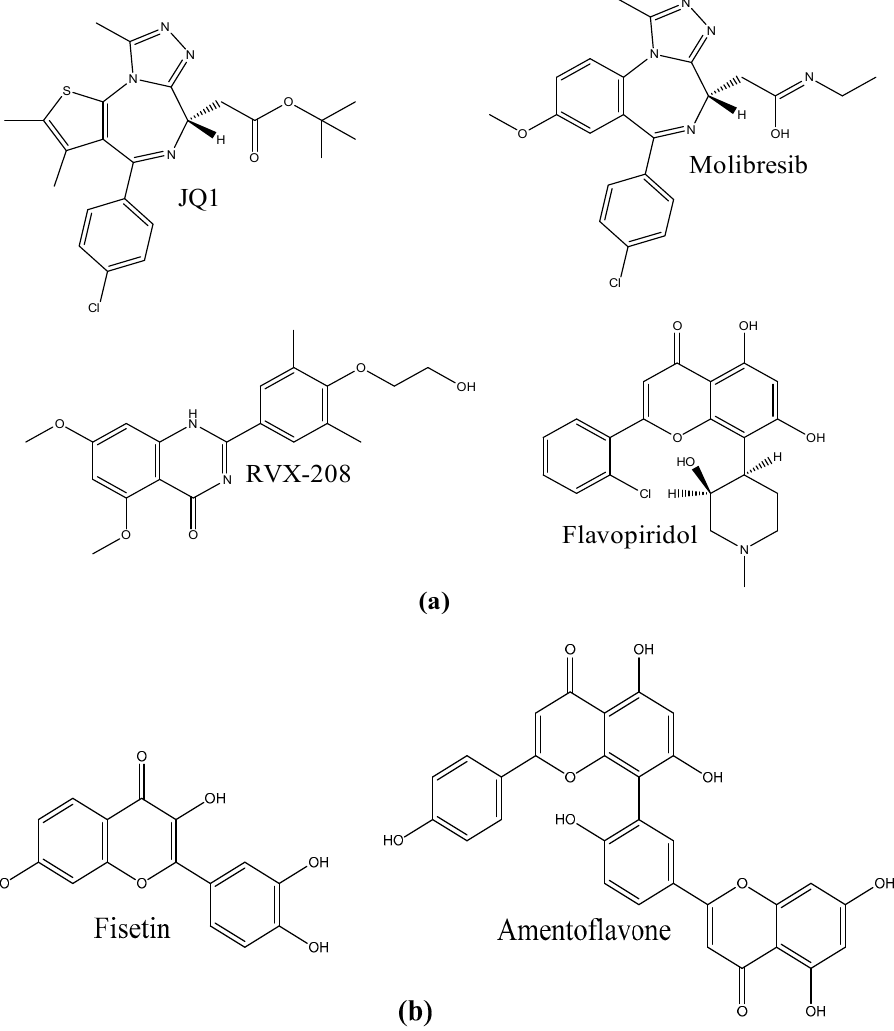
Figure 3. Chemical structures of ( a ) reference ligands for BET inhibition, and ( b ) flavonoids studied in this work.